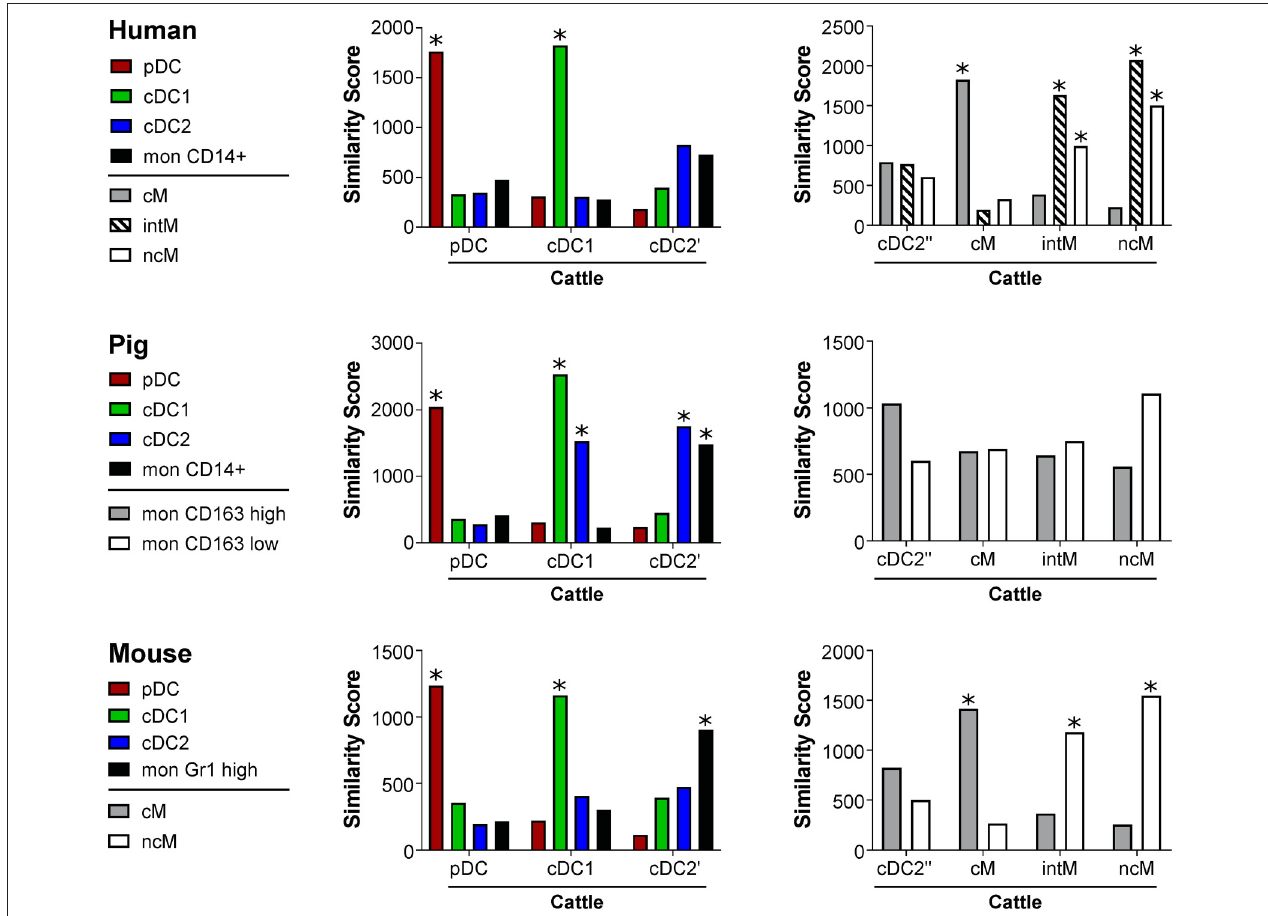
FIGURE 6 | Similarity scores. Transcriptomic profiles of bovine DC and monocyte subsets were compared with signatures of corresponding human, porcine, and murine subsets. Statistical significance of the similarity scores was determined by comparing the observed values with a null distribution obtained by reshuffling the genes.*Empirical p <